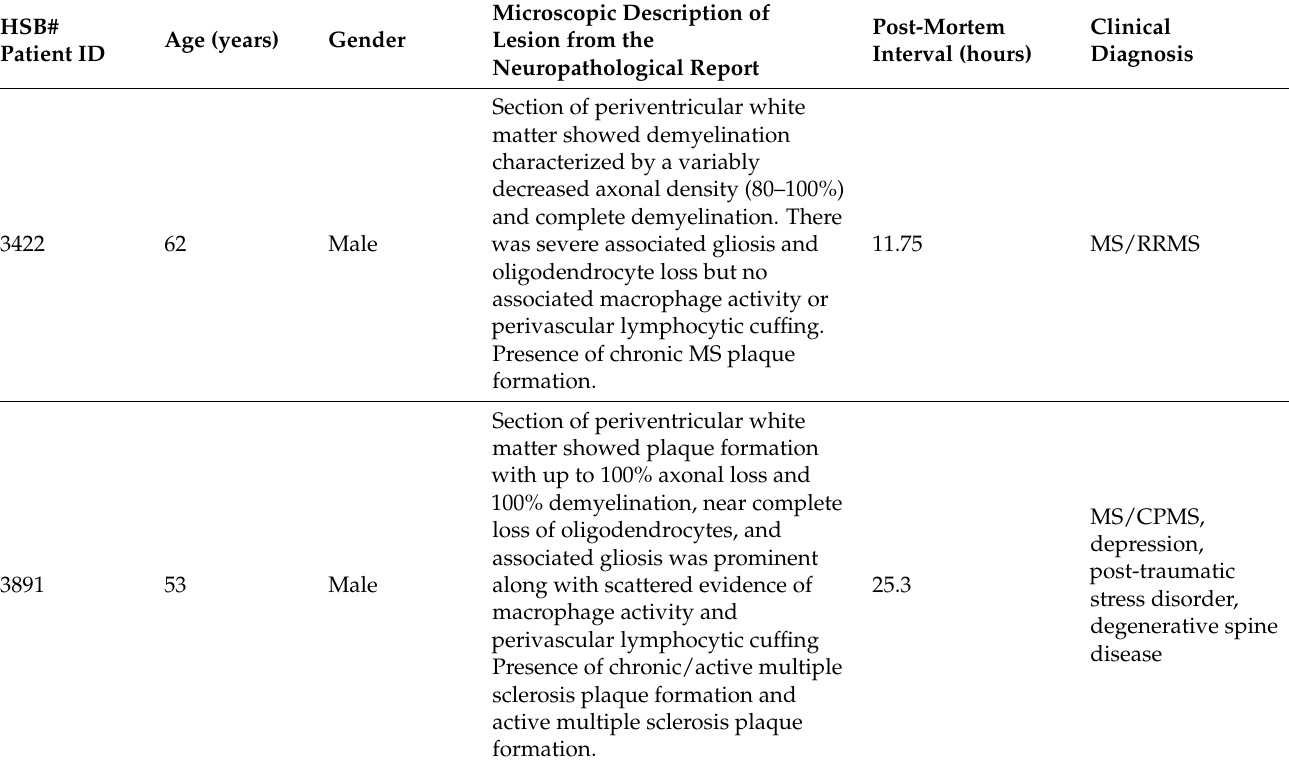
Table 1. Source of tissue specimens from control and multiple sclerosis patients employed in the